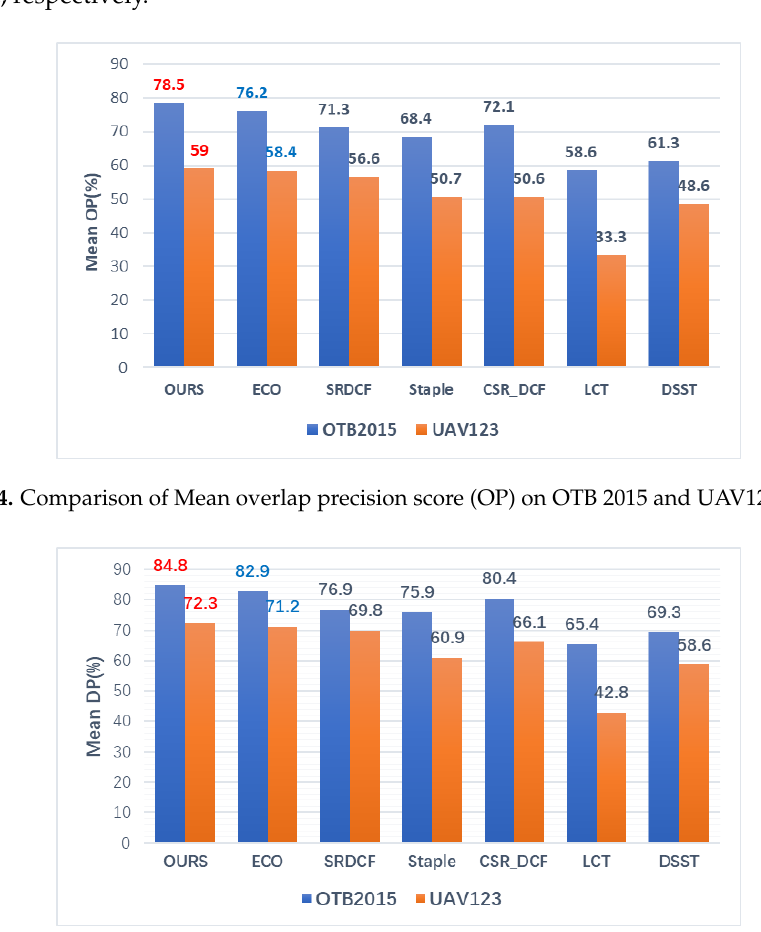
Figure 5. Comparison of Mean distance precision score (DP) on OTB 2015 and UAV123